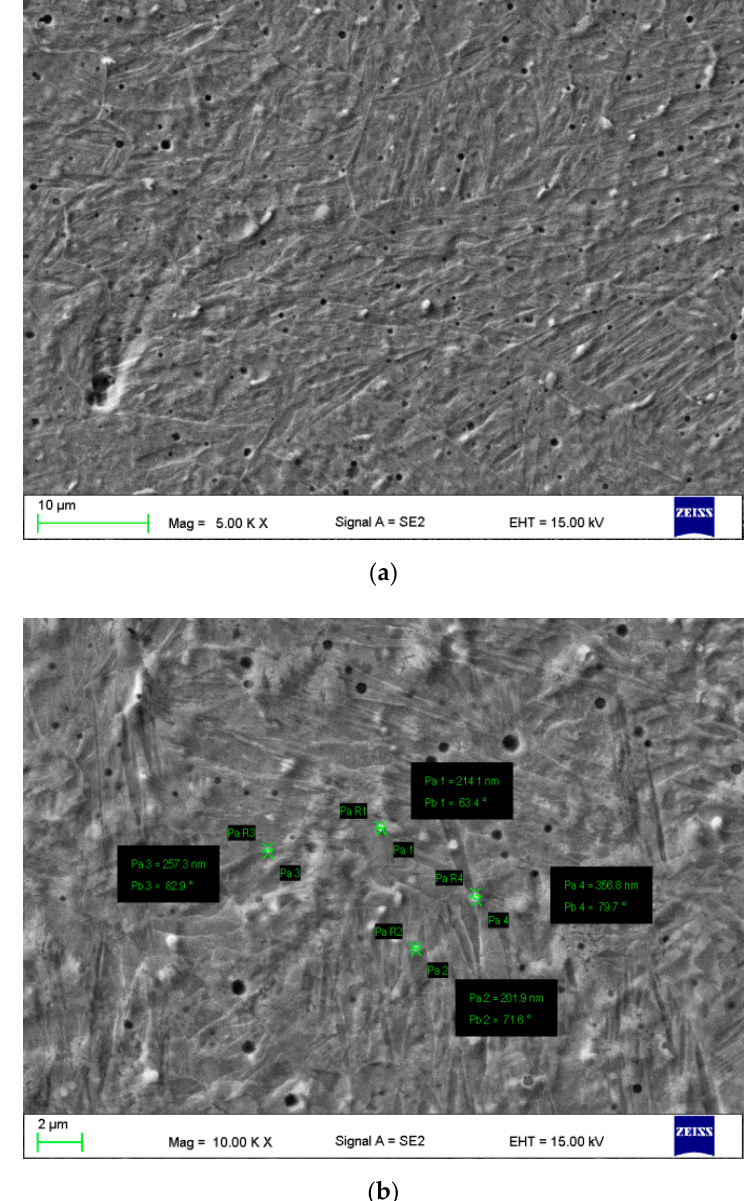
Figure 15. SEM micrograph in the middle region of the clad of stringer bead HC4 produced by the laser deposition of Fe-based powder (scanning speed 250 mm/min, laser output power 1000 W, energy input 240 J/mm) at forced cooling under cryogenic conditions in a liquid nitrogen bath (Table 3, Figures 12 and 16): ( a ) an overview of the microstructure within the dendritic regions (typical martensitic morphology); and ( b ) a close view of precipitations in interdendritic regions with measuring the dimensions (201.9 – 356.8 nm).